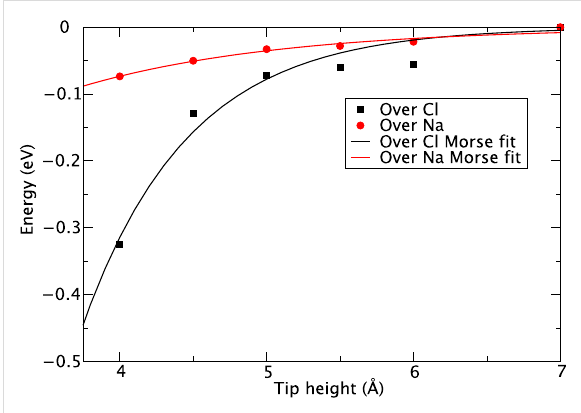
Figure 5: Total energy changes as a function of tip height for the peri- odic Cr tip interacting with the NaCl(001) surface, and Morse function curves fitted to the data